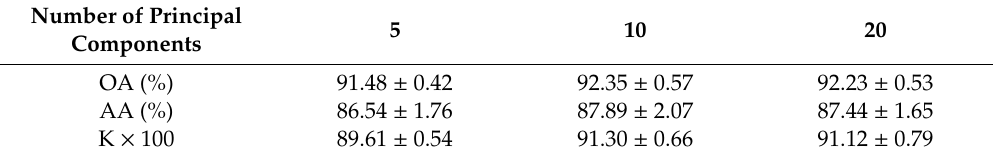
Table 3. Test accuracy of Auto-Encoder-DenseNet with di ff erent numbers of principal components.